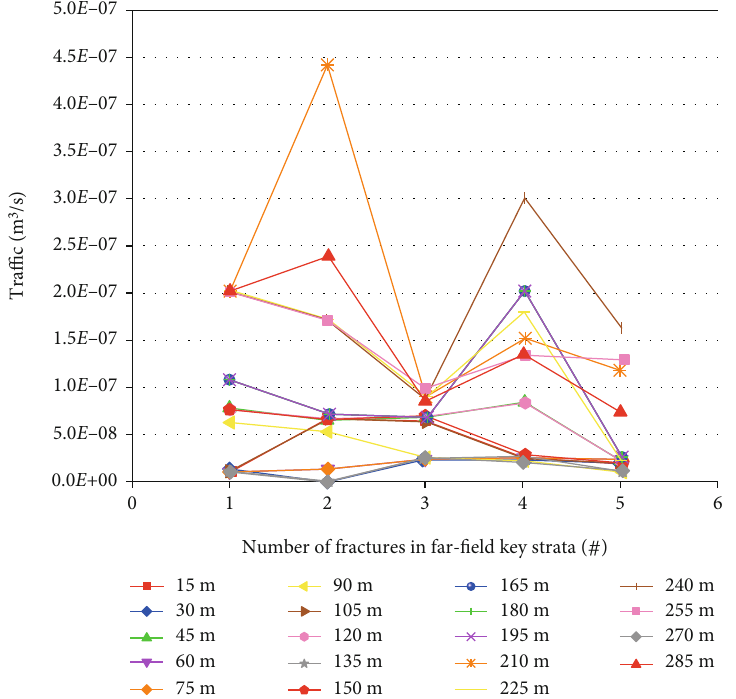
Figure 14: The fracture fl ow distribution curve in key layer 3 (far fi eld key layer).